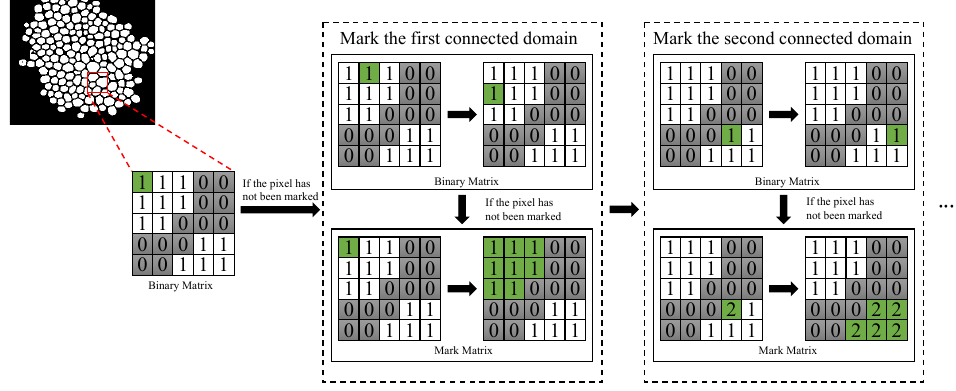
Figure 3. An example of the counting process based on the eight neighborhood